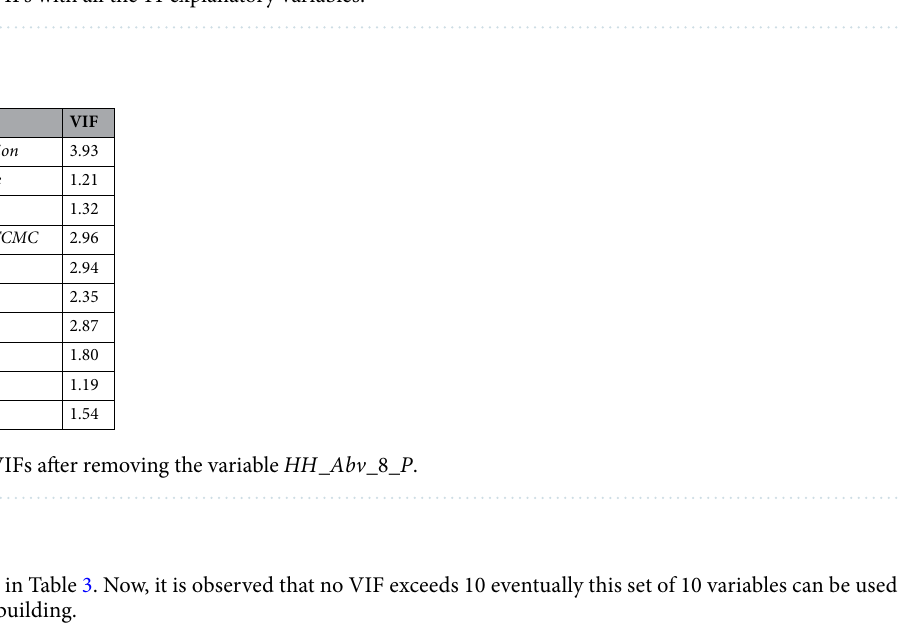
Table 2. VIFs with all the 11 explanatory variables.